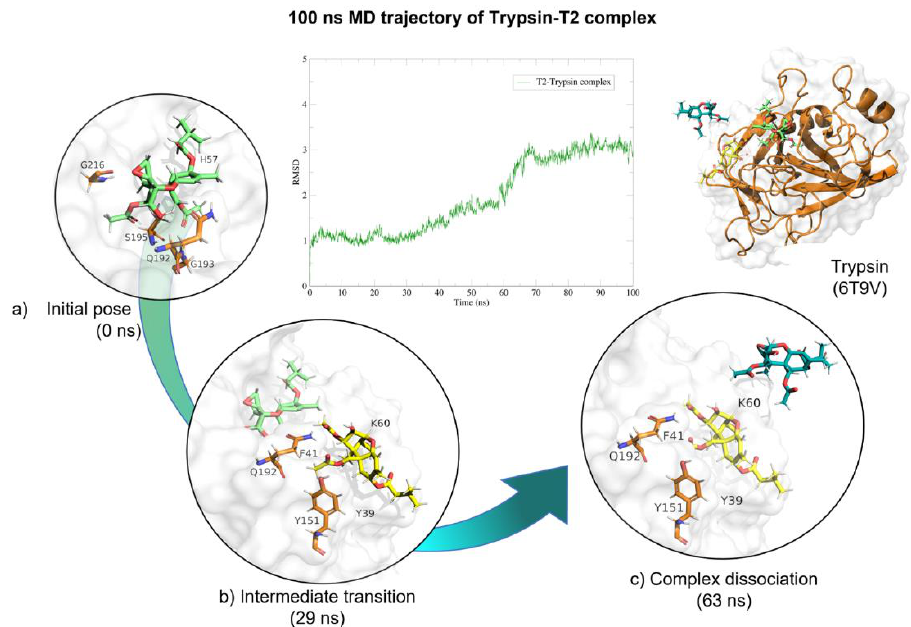
Figure 11. Molecular dynamics of trypsin – T2 complex. The root mean squared deviation (RMSD) plot shows changes in the complex conformation with respect to the initial state during 100 (ns). ( a ) Initial pose (0 ns), complex initial state obtained from molecular docking studies. ( b ) Intermediate transition pose visualization where T2 moves within the ligand binding site. ( c ) Complex dissociation, T2 becomes unbound from trypsin binding site. Green, T 2′ s initial pose; Yellow, T2 at 29 (ns); Dark green, T2 at 73 (ns).